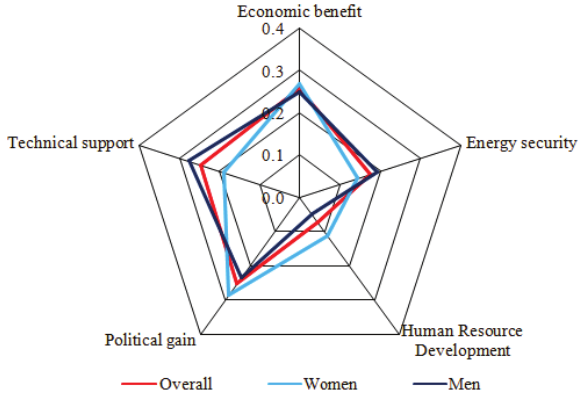
Figure 6. Cumulative and gender-wise responses to question A6: “What do you think is the main purpose behind Bangla - desh’s bilateral nuclear collaboration with Russia?”.